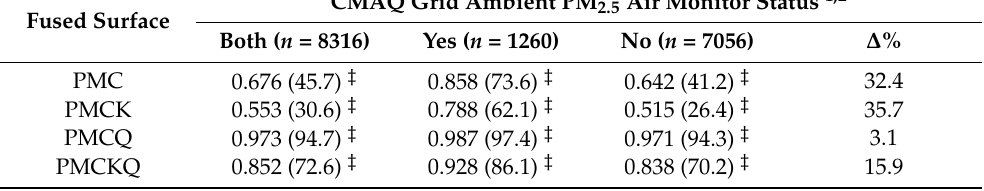
Table 4. Correlations between baseline PMB and the four AOD-PM 2.5 fused surfaces by ambient PM 2.5 air monitor status in the Baltimore study area.